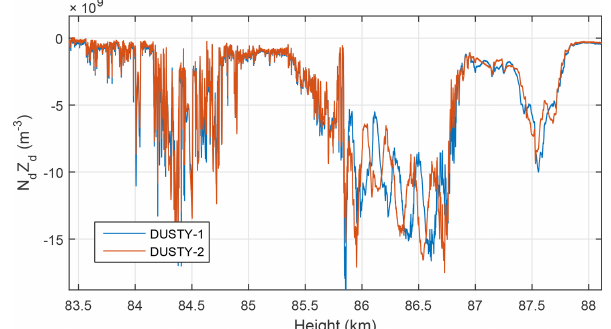
Figure 4. Dust charge number density for the identical DUSTY probes launched on the MXD-1B payload on 8 July